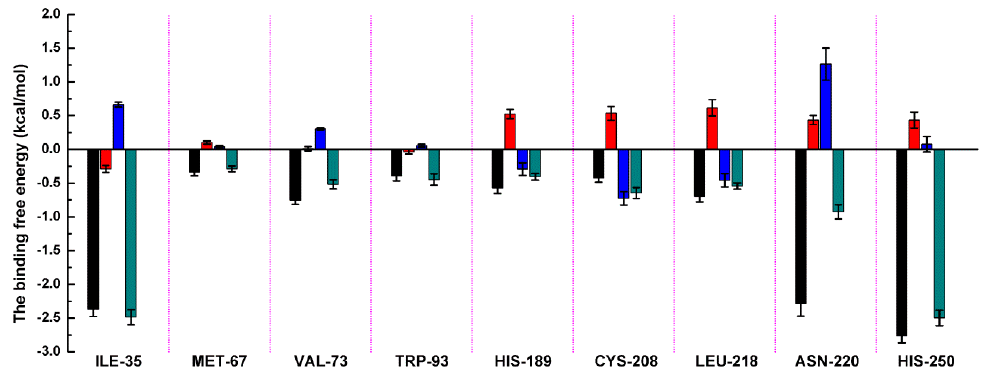
Figure 3. Decomposition of the binding energy on a per-residue basis in the NDM-1-ZINC05683641 by the MM-GBSA method. The histogram chart shows the van der Waals (black), electrostatic (red), solvation (blue), and total (green) contributions for the complexes.